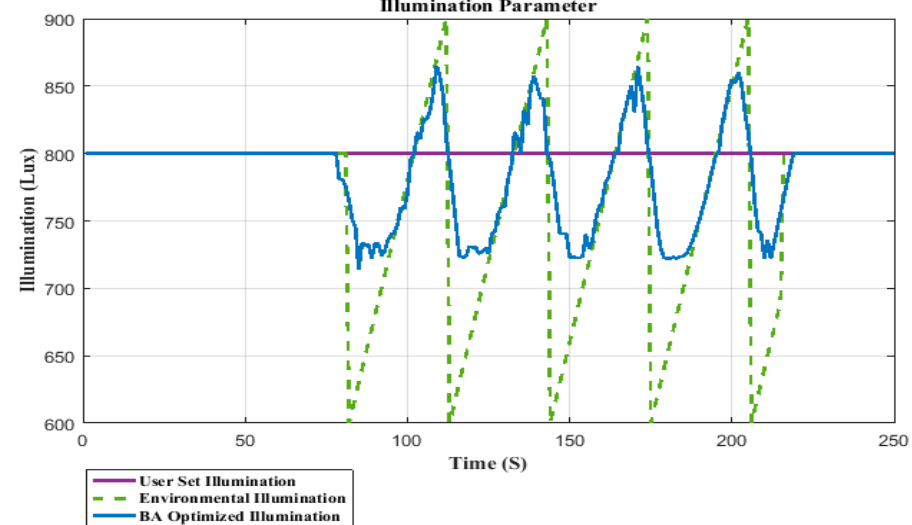
Figure 10. User set parameter, environmental parameter and BA optimize Illumination values.